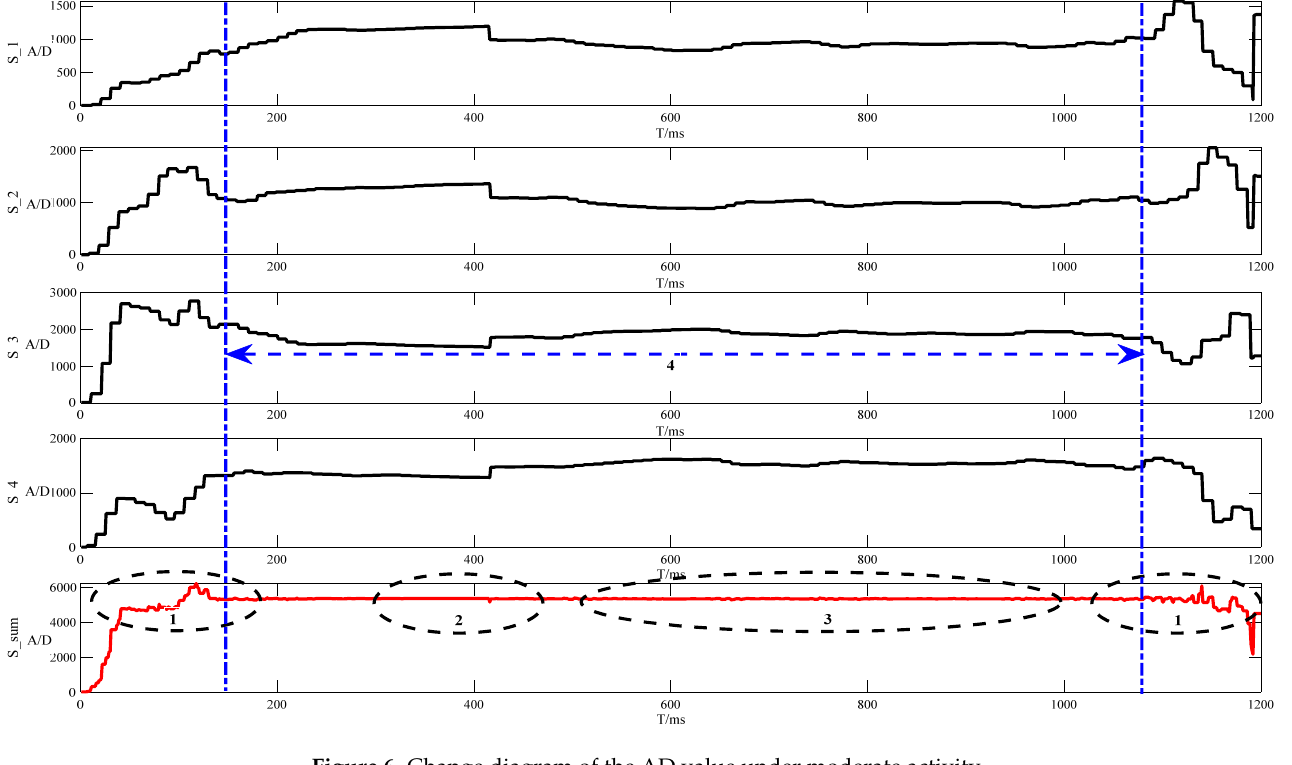
Figure 6. Change diagram of the AD value under moderate activity.